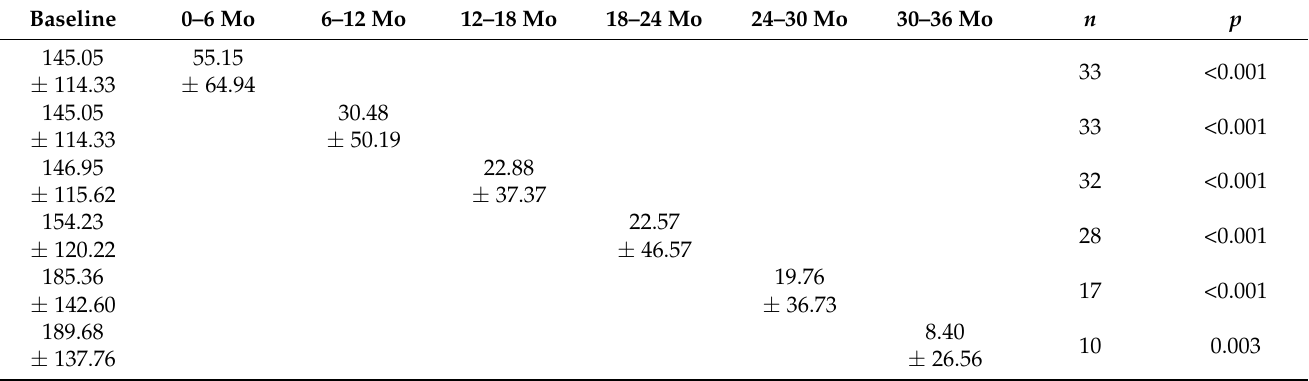
Figure 1. Changes in six-month dosage of oral steroid. Red dotted line, average of methylpred- nisolone intake (mg). Abbreviation: Mo, months. Table 1. Dosage of oral systemic steroid (methylprednisolone, mg) (paired t -test).